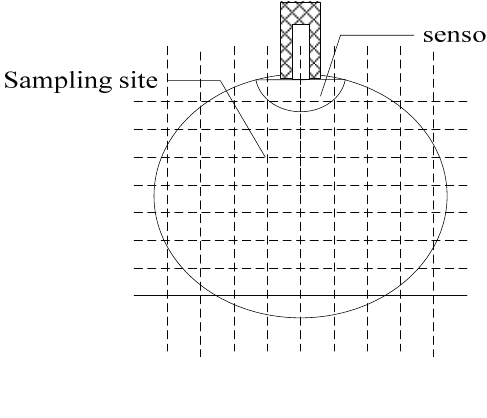
Figure 8. Sampling sites of the spatial